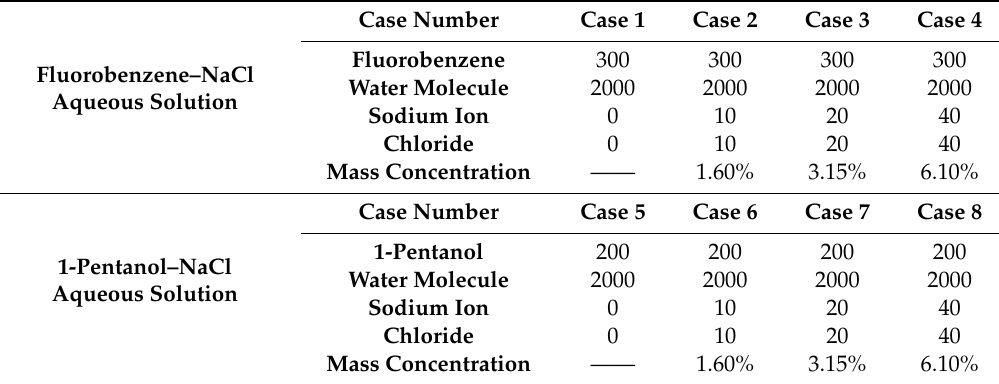
Fluorobenzene–NaCl